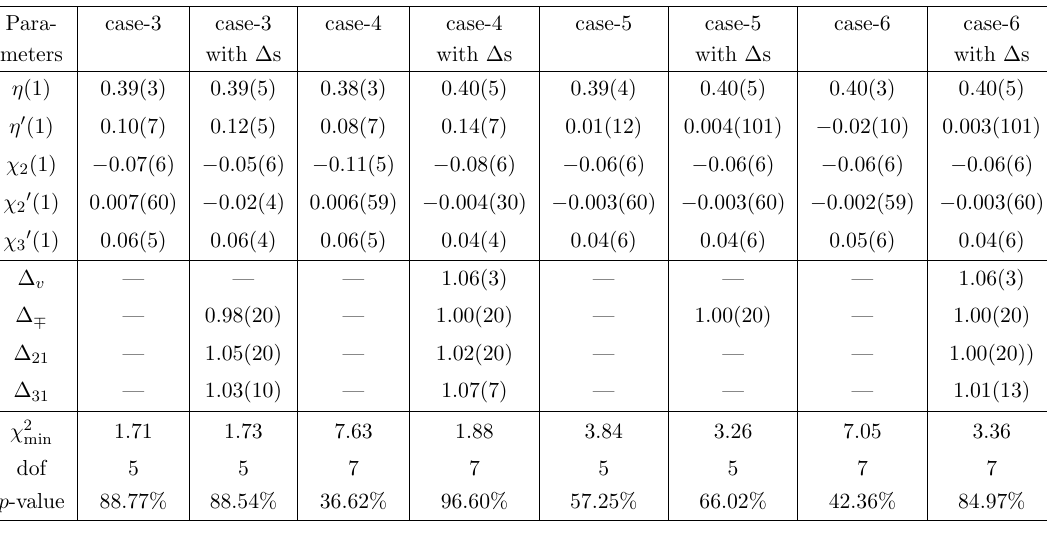
Table 14 . The (cid:12)t results for the subleading Isgur-Wise parameters with (cid:31) 2 (1), (cid:31) 0 varied within their QCDSR 3 (cid:27) range.